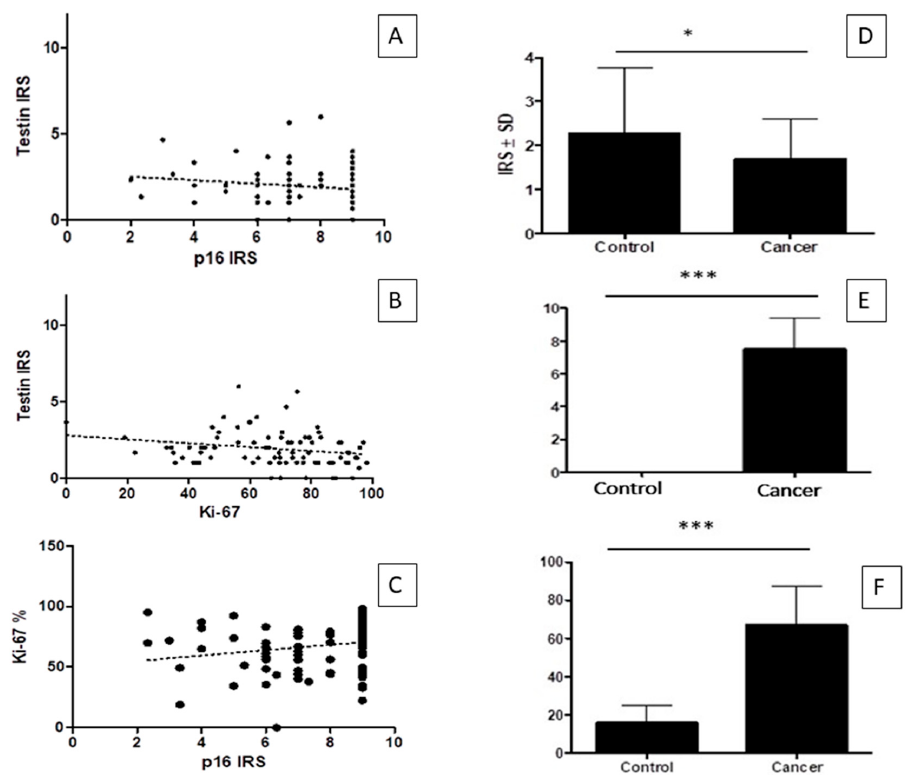
Figure 1. Immunohistochemical reactions in cervical cancer samples: ( A ) testin and p16 correlation in cervical cancer; ( B ) testin and Ki-67 correlation in cervical cancer; ( C ) Ki-67 and p16 correlation in cervical cancer; ( D ) testin expression in cervical cancer and control group; ( E ) p16 expression in cervical cancer and control group; ( F ) Ki-67 expression in cervical cancer and control group * p < 0.05 and *** p < 0.001.